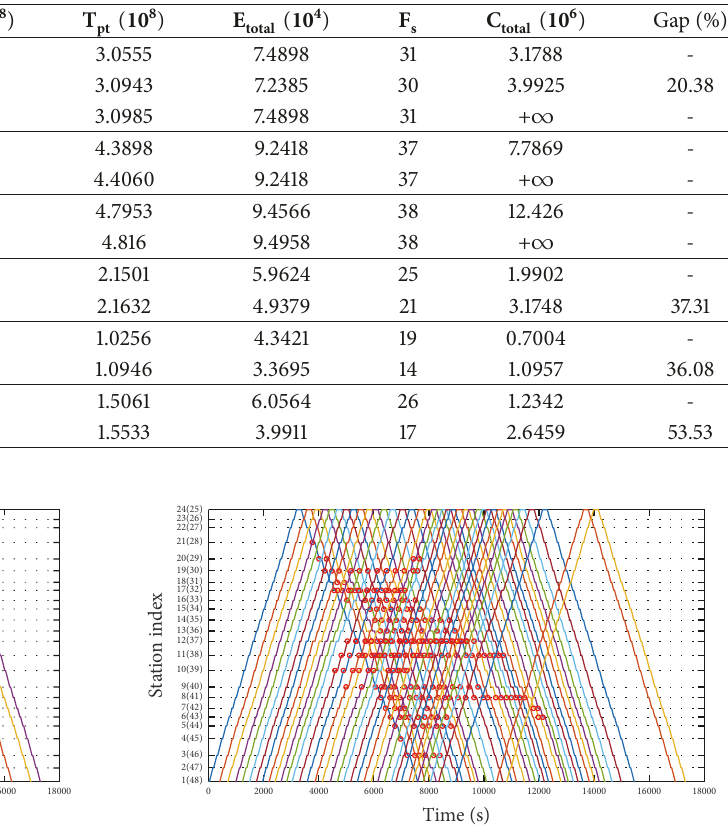
Figure 12: Timetable for morning peak (case a-1). Figure 13: Timetable for evening peak (case b).